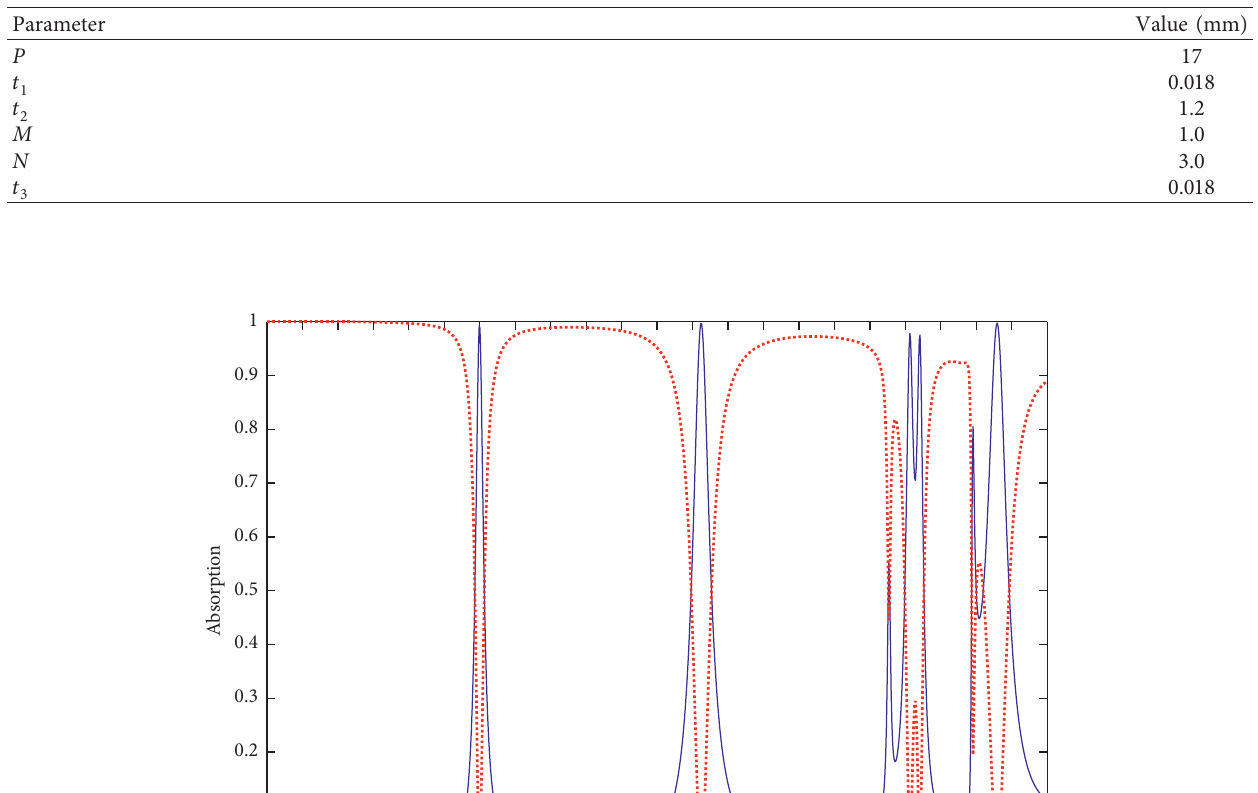
Figure 1: View of the unit cell: (a) proposed MMA; (b) top view and side view. Table 1: Top layer metal resonator unit cell dimensions.